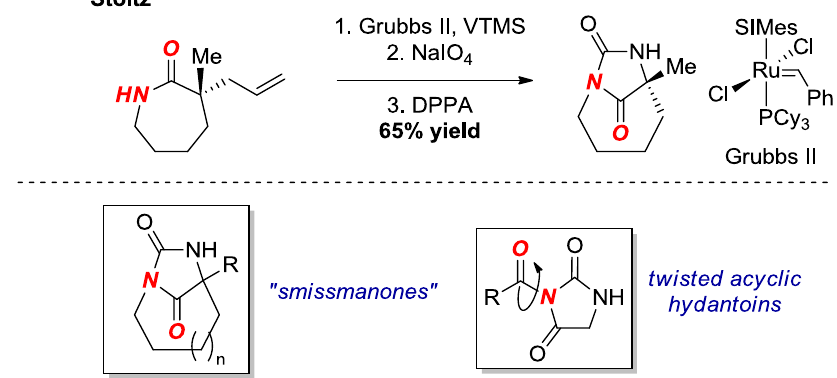
Figure 11. Fragment-Based Drug Discovery using Bridged Lactams.